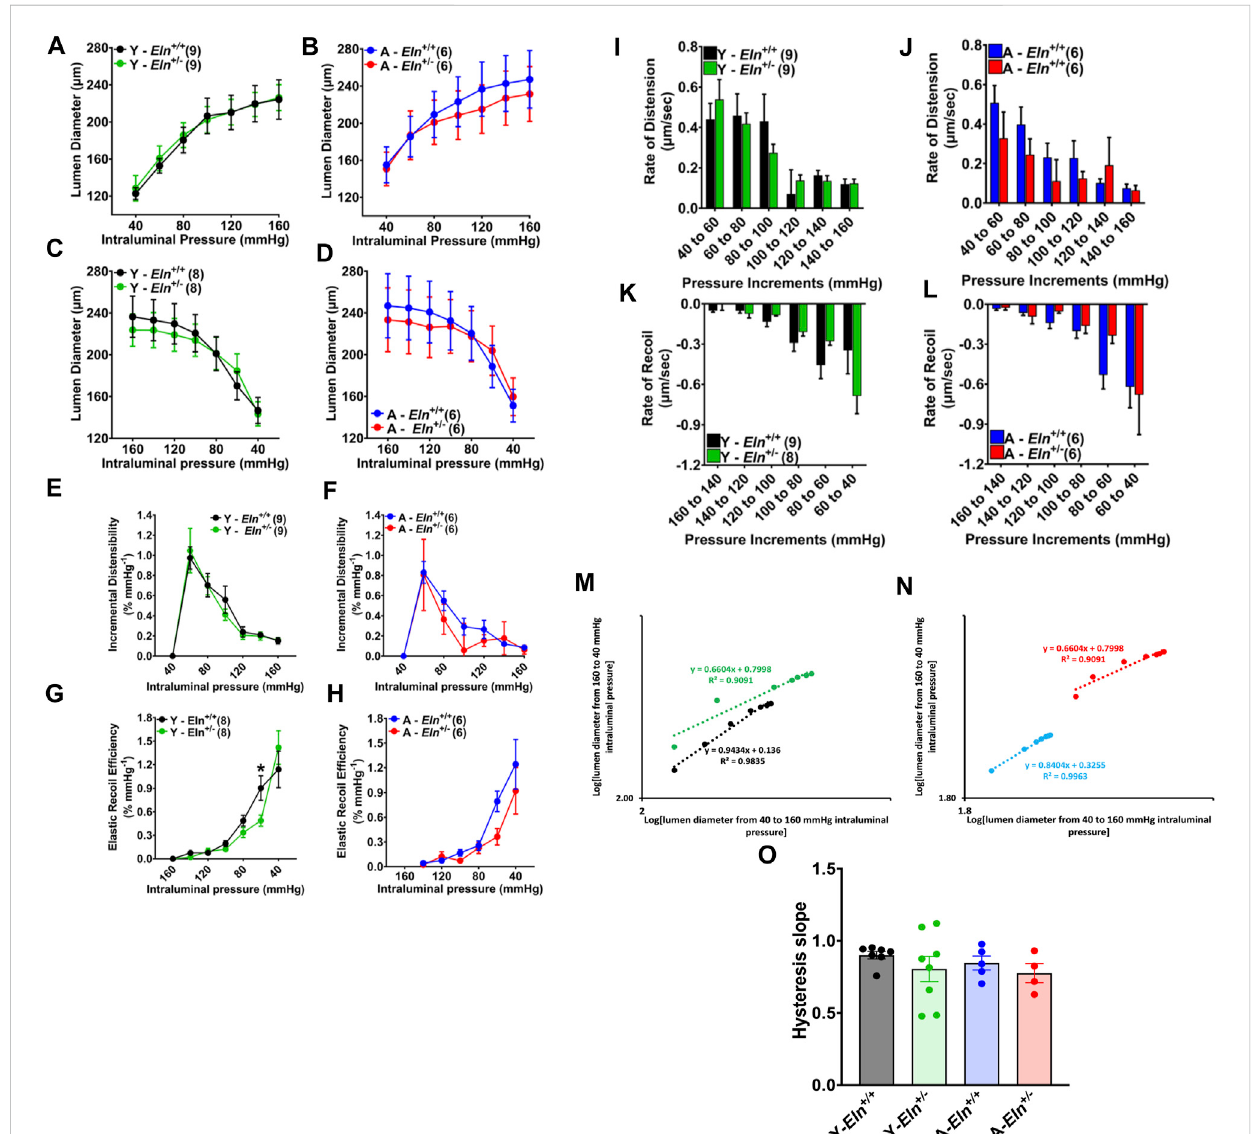
FIGURE 3 Effects of elastin insuf fi ciency and aging on the biomechanical properties of renal interlobar arteries of young and aged Eln +/+ and Eln +/ − female mice. (A – D) Passive response of interlobar arteries to pressure loading and unloading in young and aged Eln +/+ and Eln +/ − female mice. Intraluminal pressure in 20 mmHg increments or decrements was applied to cannulated interlobar arterial segments in Ca 2+ free HEPES buffer at 37 ° C. (E – H) Incremental distensibility and elastic recoil ef fi ciency of interlobar arteries from young and aged Eln +/+ and Eln +/ − female mice in response to increasing or decreasing intraluminal pressure. (I – L) Rates of lumen diameter changes in response to increases and decreases in intraluminal pressure in interlobar arteries from young and aged Eln +/+ and Eln +/ − female mice. (M,N) Representative correlations of interlobar artery lumen diameters as intraluminalpressurewasincreasedfrom40to160 mmHg( x -axis)anddecreasedbackfrom160to40 mmHg( y -axis).Theslopeofthetrendlines(dotted lines)indicatesthelevelofhysteresis. (O) AsummarybargraphshowingtheaverageslopeofthecorrelationgraphsillustratedinMforarteriesfromyoung and aged Eln +/+ and Eln +/ − mice. All values are mean ± s.e.m. * p < 0.05. The number of animals per group is 6-8 mice. Y, young; A,